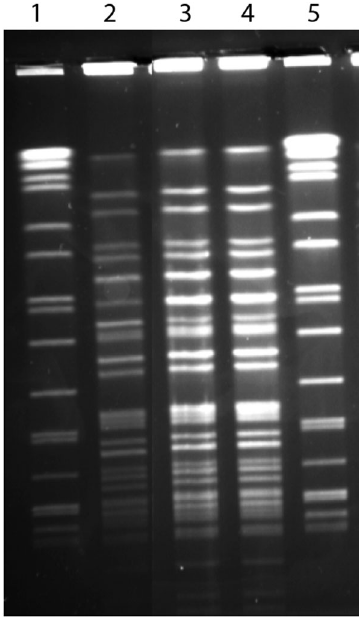
Figure 2: Pulsed- fi eld gel electrophoresis of the three Acinetobacter bau- mannii isolates. Lane 1: Control strain; Lane 2: Isolate (collection date: June 25, 2015); Lane 3: Isolate (collection date: August 17, 2015); Lane 4: Isolate (collection date: August 24, 2015); Lane 5: Control